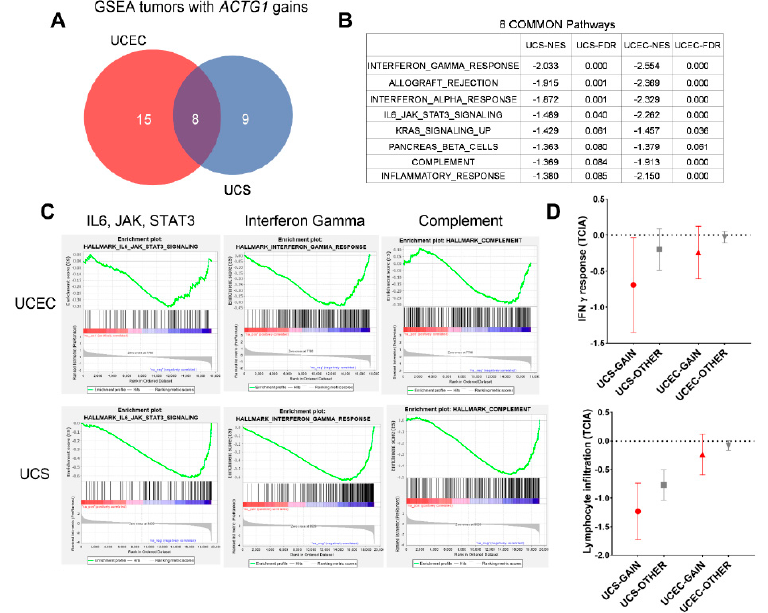
Figure 5. UCEC and UCS with ACTG1 gains are associated with a reduction in an interferon gamma response (IFN- γ ) response. ( A ) Venn diagram represents GSEA analysis of UCEC and UCS with ACTG1 gains from TCGA, with the numbers representing statistically significant gene sets (FDR < 0.1) ( B ) 8 gene programs are consistently enriched in UCEC and UCS with ACTG1 gains. The net enrichment scores (NES) and false discovery rates (FDR) are shown. ( C ) Enrichment plots of ACTG1 in UCS and UCEC cohorts show de-enrichment in interleukin-6 (IL6) and IFN- γ . ( D ) Based on aggregating TCIA data, the IFN- γ response and lymphocyte infiltration tumors examined within the UCS and UCEC cohorts and grouped by ACTG1 gain (red) and without (grey). The mean response is shown as well as a 95% confidence interval (CI). A p -value of less than 0.1 was considered